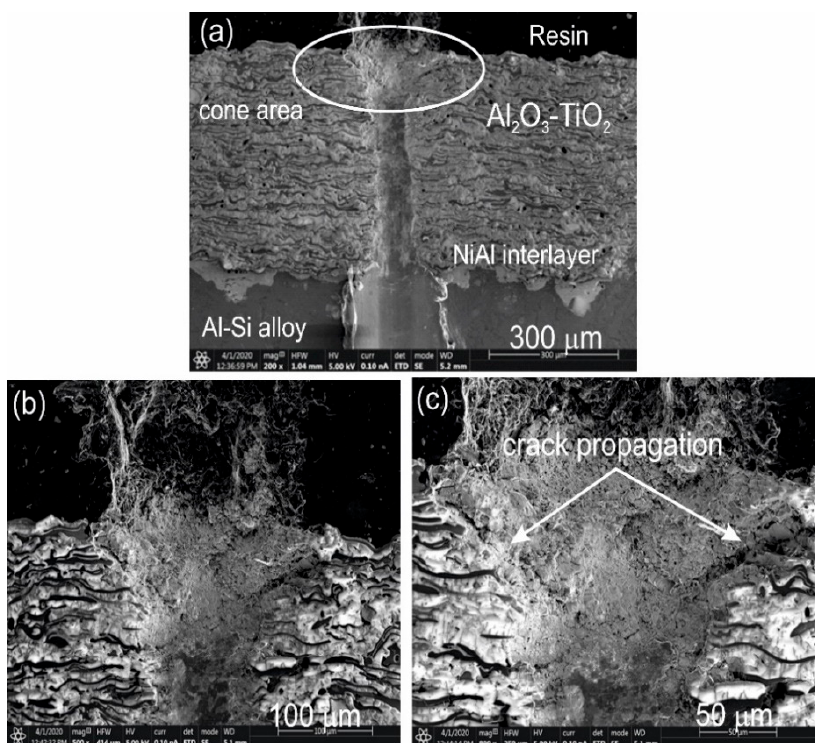
Figure 12. ( a ) SEM micrograph of the cross-sectional area of the Al 2 O 3 -15 wt.% TiO 2 /NiAl/Al-Si coating system cracked after the scratch test, ( b ) and ( c ) magnified area selected in Figure 12a.